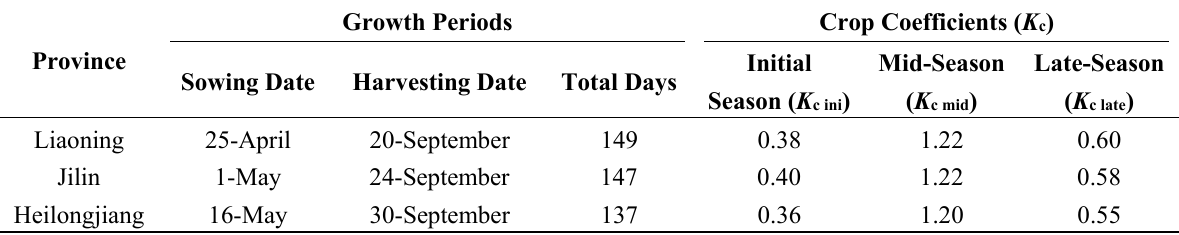
Figure 2. The maize sowing area and yield at the prefecture level in 2012. Table 1. Growth periods and literature values of crop coefficient K c for maize in Liaoning, Jilin and Heilongjiang